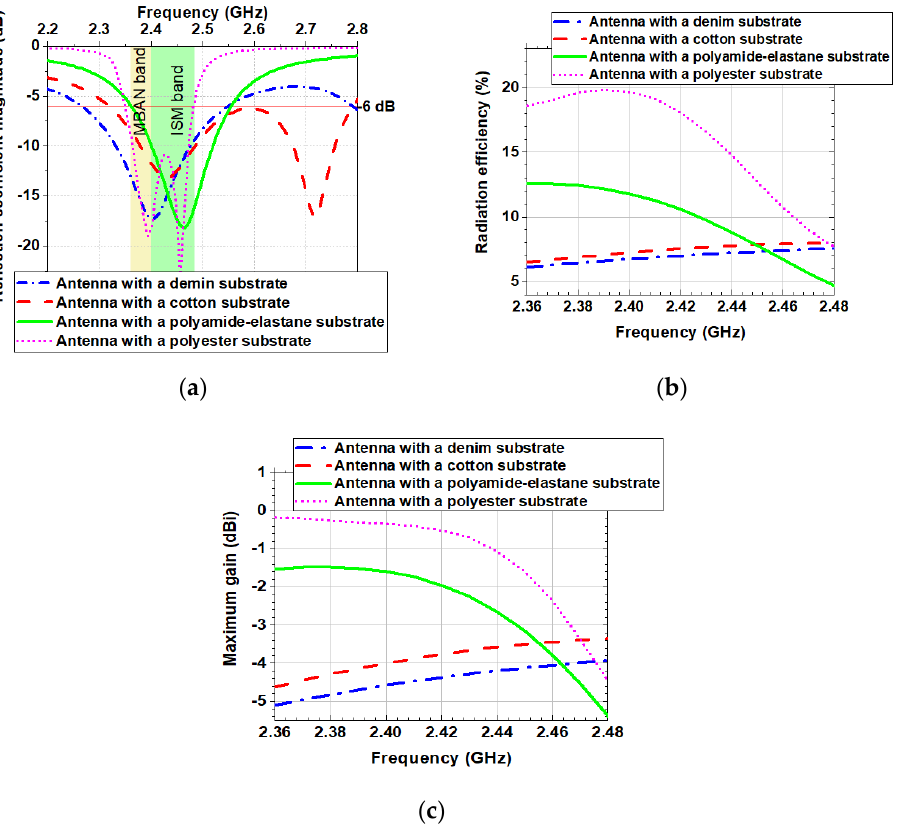
Figure 11. Simulated on the phantom: ( a ) Reflection coefficient magnitudes versus frequency; ( b ) Radiation efficiency versus frequency; ( c ) Maximum gain versus frequency.